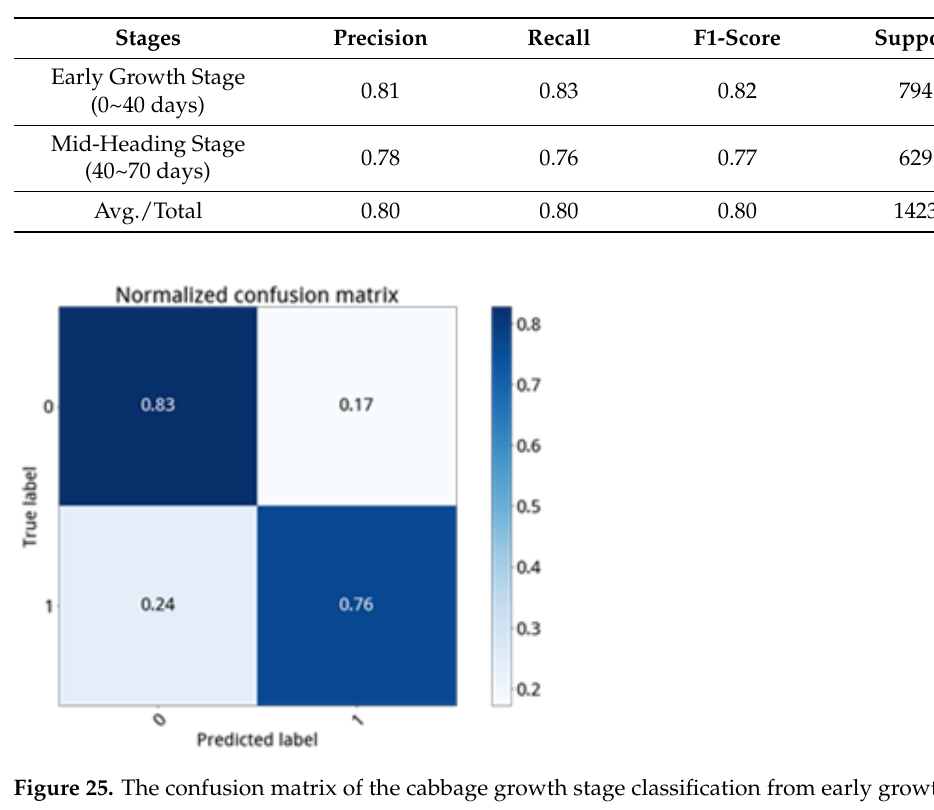
Table 11. Growth stage classification results of cabbage from early growth and mid-heading stages.